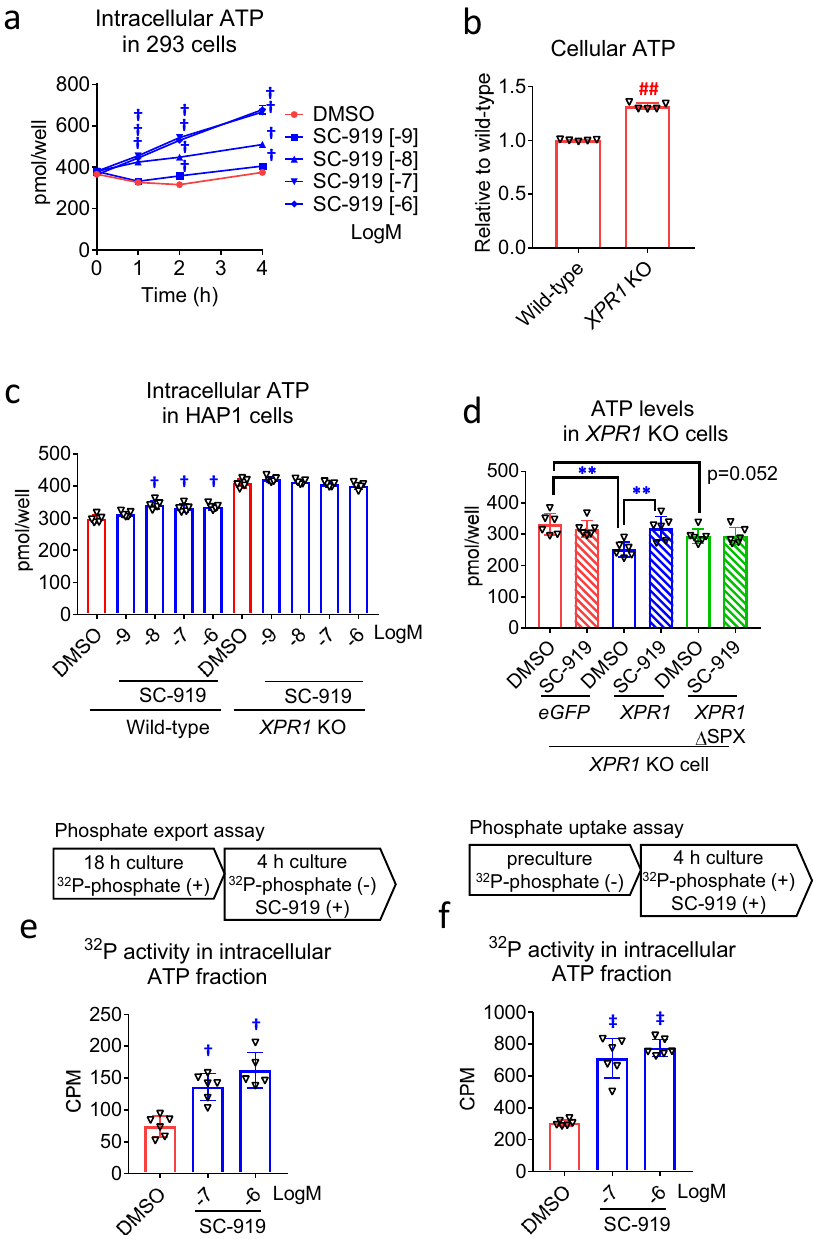
Fig. 5 IP6K inhibition increases the intracellular levels of ATP in an XPR1 -dependent manner. a Time course of ATP levels in SC-919-treated 293 cells. b Intracellular levels of ATP in HAP1 wild-type and XPR1 KO cells. Effects of the treatment with SC-919 after 4 h on c intracellular levels of ATP in HAP1 wild- type and XPR1 KO cells, d intracellular levels of ATP in XPR1 KO cells introduced with either eGFP , XPR1 , or inositol pyrophosphates-binding site-deleted XPR1 ( XPR1 Δ SPX) treated with either DMSO or SC-919 (1 μ M), e 32 P activity in ATP in 293 cells pre-treated with 32 P-phosphate followed by SC-919 treatment, f 32 P activity in ATP in 293 cells pre-treated with non-labelled phosphate followed by SC-919 plus 32 P-phosphate treatment. Values indicate mean ± S.D. ( n = 5 biological replicates for a – c , 5 – 6 biological replicates for e , and 6 biological replicates for d, f ). † P < 0.05 and ‡ P < 0.05 vs. vehicle as determined using Williams ’ test and Shirley – Williams test, respectively. ** P < 0.01 as determined using Student ’ s t -test, and ## P < 0.01 as determined using the Aspin – Welch test. CPM, counts per